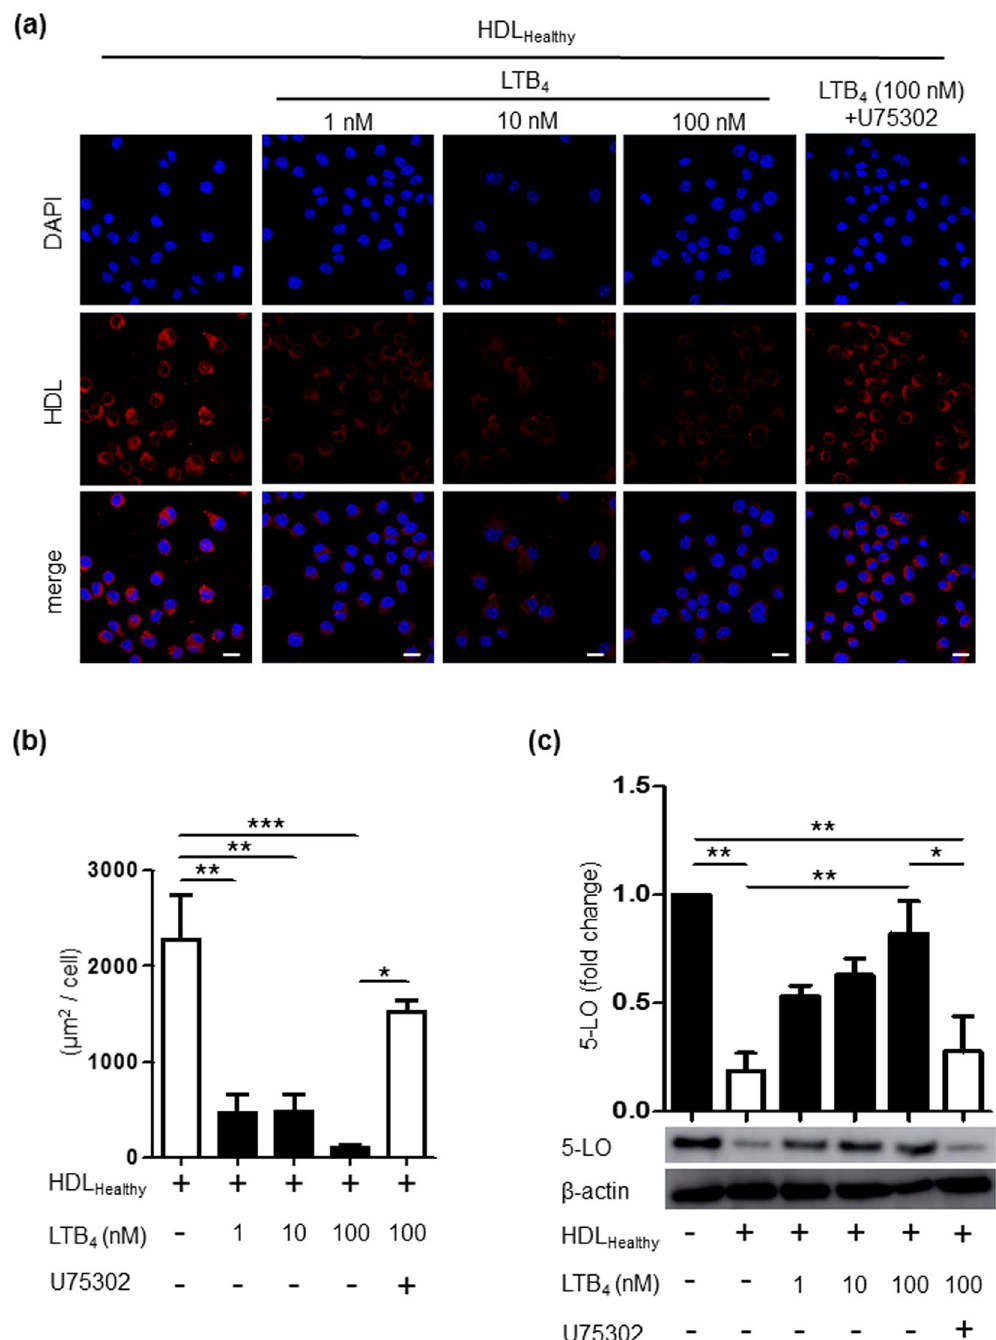
Figure 4. LTB 4 attenuated HDL engulfment and HDL-mediated 5-LO degradation. ( a ) Macrophages were pretreated for 30 min at 37 °C with the BLT1 inhibitor U75302 (300 nM) or vehicle, and then incubated with LTB 4 (100 nM) for 30 min at 37 °C and subsequently with DiI-labelled HDL Healthy (shown as red) for 30 min at 37 °C. ( b ) The DiI-positive area in macrophages ( μ m 2 /cell) was quantified by ImageJ (Scale bar = 10 μ m). The data are shown as the mean ± SEM of 3 independent experiments. * P < 0.05, ** P < 0.01, *** P < 0.005. ( c ) Macrophages were pretreated for 30 min at 37 °C with U75302 (300 nM) or vehicle and were then incubated with LTB 4 (1-100 nM) for 30 min at 37 °C and subsequently with 10 μ g of HDL Healthy for 30 min at 37 °C. Lysates were collected for western blot analysis of 5-LO. The data are shown as the mean ± SEM of 3 independent experiments. * P < 0.05, ** P <